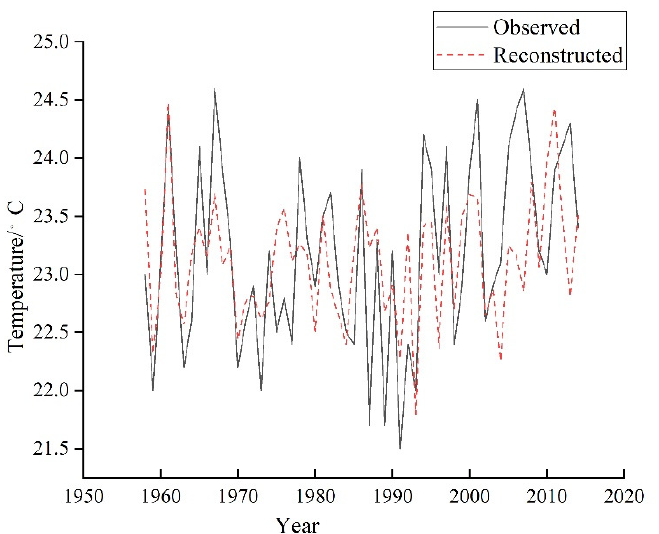
Figure 7. Comparison of the reconstructed and observed T MJ in the Tongbai Mountains from 1958 to 2018.